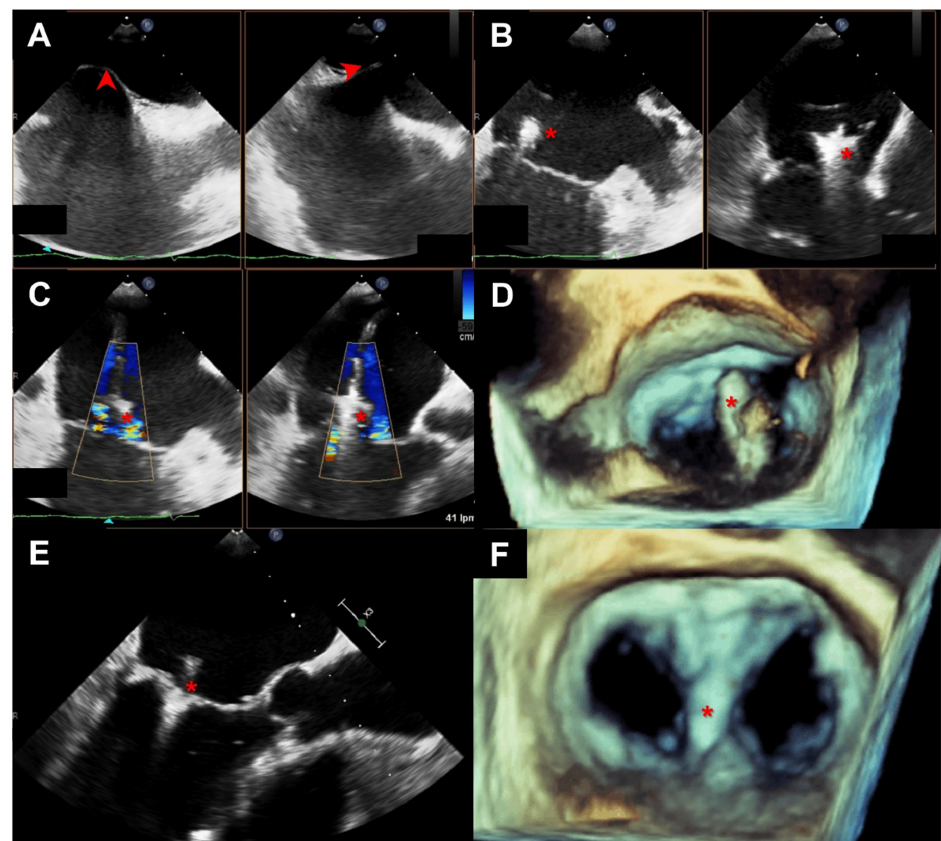
Figure 1. Intraprocedural TEE guidance during TEER with MitraClip. Firstly, transeptal puncture at the superior and posterior portion of fosa ovalis ( arrow head ) should be monitored ( A ). Afterwards MitraClip ( asterisk ) delivery catheter is deflected towards the mitral valve ( B ) and directed against the origin of the regurgitant jet ( C ). Three-dimensional view of the mitral valve helps on perpendicular orientation of the device ( D ). After grasping of both mitral leaflets ( E ) a double-orifice valve results from the procedure ( F ). TEE: transesophageal echocardiogram; TEER: transcatheter edge-to-edge mitral repair.